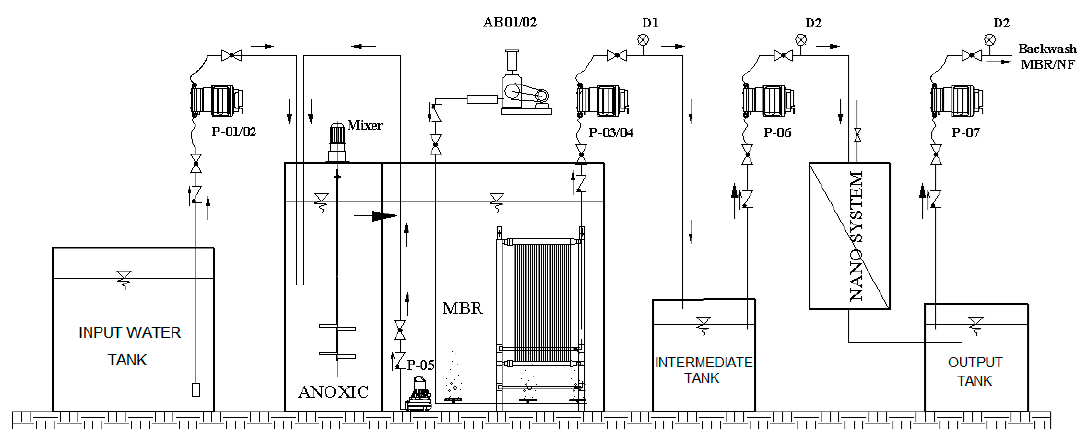
Figure 1. Experimental model process of membrane bioreactor nanofiltration system.